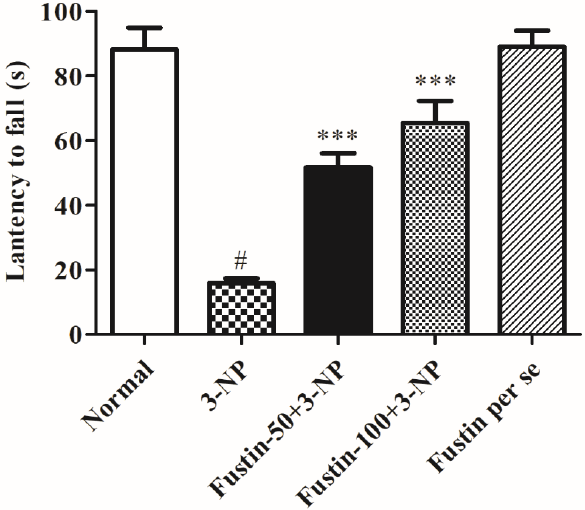
Figure 3. Effect of fustin on gripping strength against 3-nitropropionic acid-induced Huntington’s- like effects in rats. Values are expressed as mean ± S.E.M. ( n = 6). Values are statistically significant at # p < 0.05 vs. negative control group, *** p < 0.001 vs. 3-nitropropionic acid, respectively (One-way ANOVA followed by Tukey’s test).